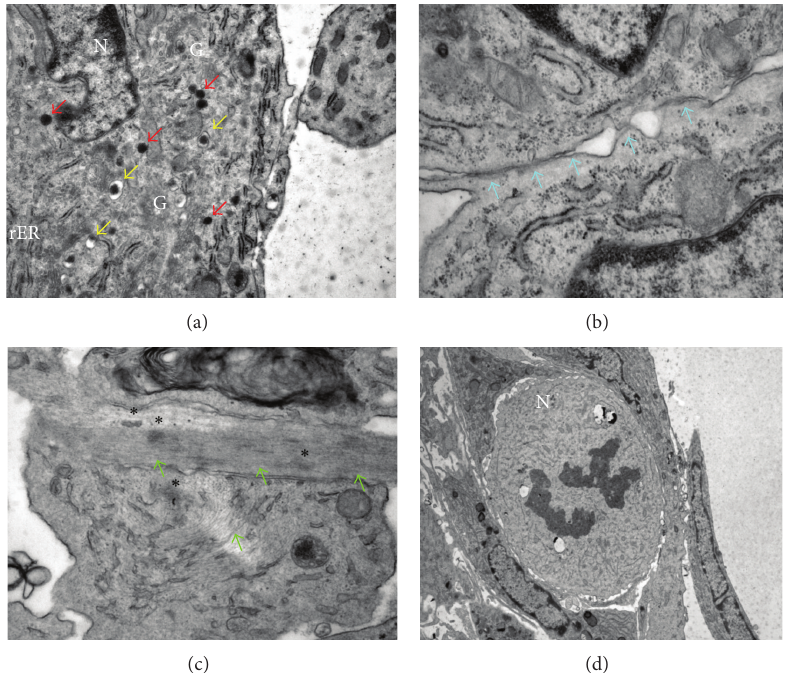
Figure 2: Electron-microscopical analysis of human CS ultrastructure. (a) Secretory granules (red arrows); primary lysosomes (yellow arrows). (b) Intercellular contacts (blue arrows). (c) Intracellular, unorganized thick filaments (green arrows); dense bodies (asterisks). (d) Mitosis (N, nucleus; G, Golgi apparatus; rER, rough endoplasmic reticulum). formation of CSs compared with nondepleted